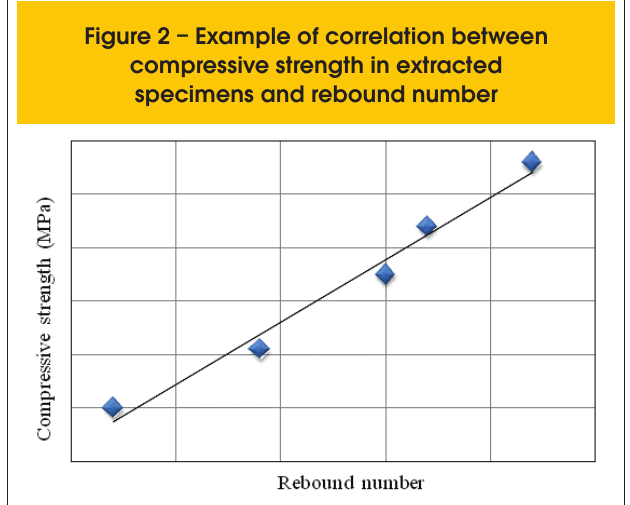
curves (rebound number versus strength of concrete provided with the equipment) very reliable. Figure 2 – Example of correlation between